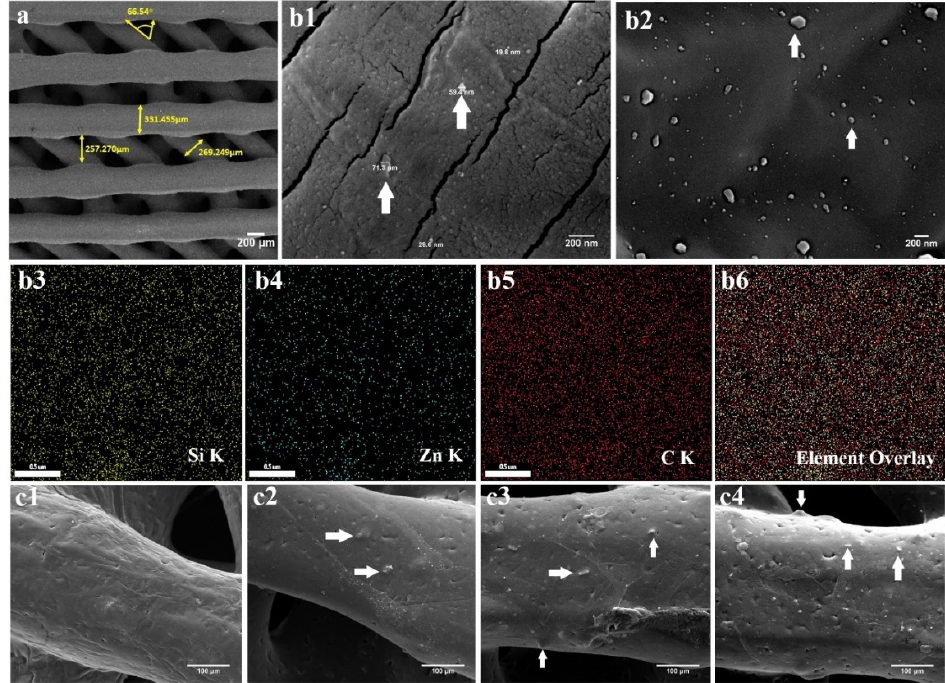
Figure 2. PCL/npW Composite scaffolds characterization. ( a ) SEM microscopy of diameter and orientation of 3D-printed scaffold strands. ( b1 , b2 ) SEM-MAP image showing the distribution of npW nanoparticles in the composite. ( b3 – b6 ) Element surface distribution of Si, Zn, and C and combined view of them by SEM-EDX. SEM image of the surface of a strand of ( c1 ) neat PCL, ( c2 ) PCL/2.5% wt. npW, ( c3 ) PCL/5% wt. npW and ( c4 ) PCL/10% wt. npW Nanoparticles embedded in scaffolds are marked with arrows.